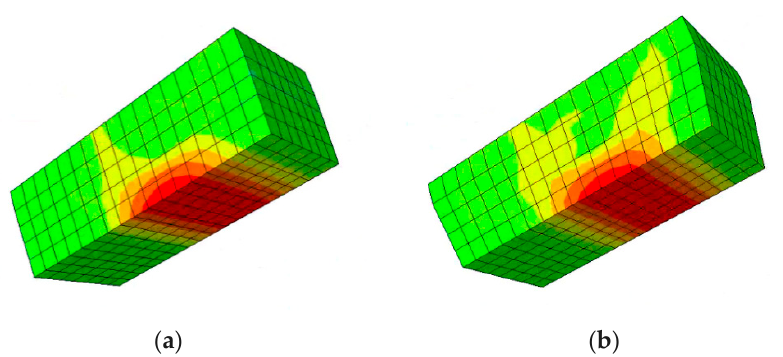
Figure 29. Stress cloud diagram of bearing block under lateral and vertical coupled load. ( a ) bearing block of TLVT. ( b ) bearing block of ILVT.